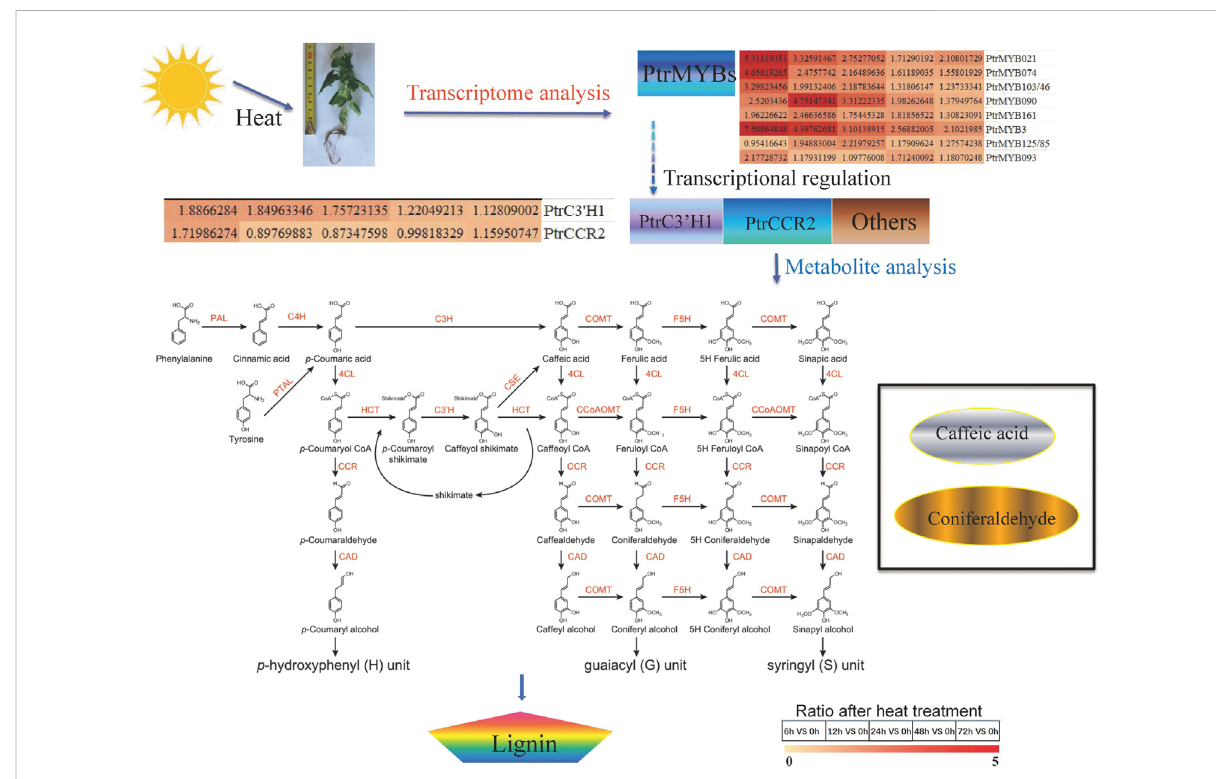
FIGURE 7 Regulatory mechanism between high temperature and lignin content. High temperature brings about the increased lignin content. Transcriptome analysis indicated that some vital transcription factors such as PtrMYBs, others lignin related transcription factors and lignin-related structural gene such as PtrC3 ’ H1 , PtrCCR2 were induced by high temperature. PtrC3 ’ H1 may be a possible factor leading to the decrease of caffeate content, while PtrCCR2 may bring about the lessen of coniferaldehyde. caffeate, coniferaldehyde represents the different lignin